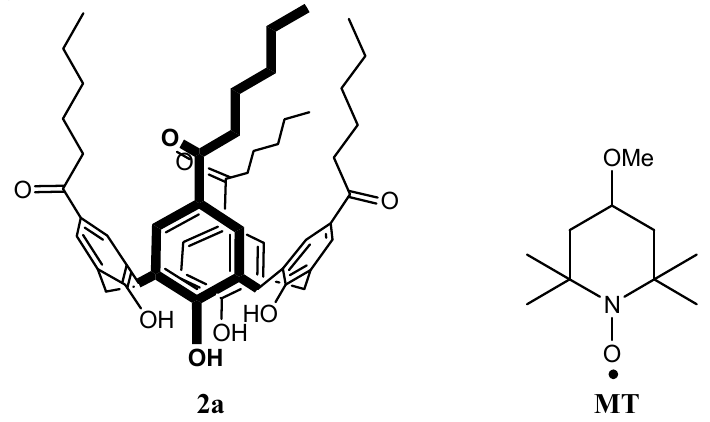
Figure 14. Structures of para -hexanoyl calix[4]arene ( 2a ) and